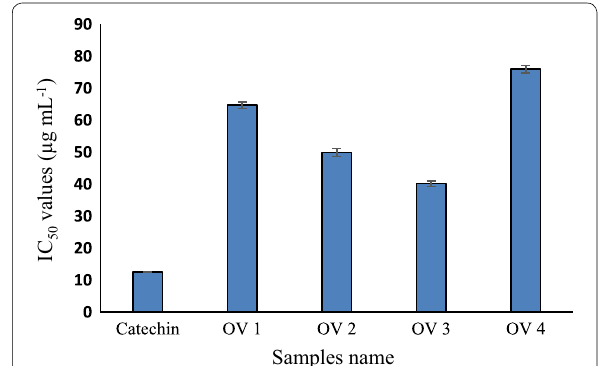
Fig. 1 DPPH-free radical scavenging activity of O. vulgare extracts (OV 1, OV 2, OV 3 and OV 4) and catechin. The results are expressed in terms of IC 50 values indicating the concentrations required to scavenge 50% of the free